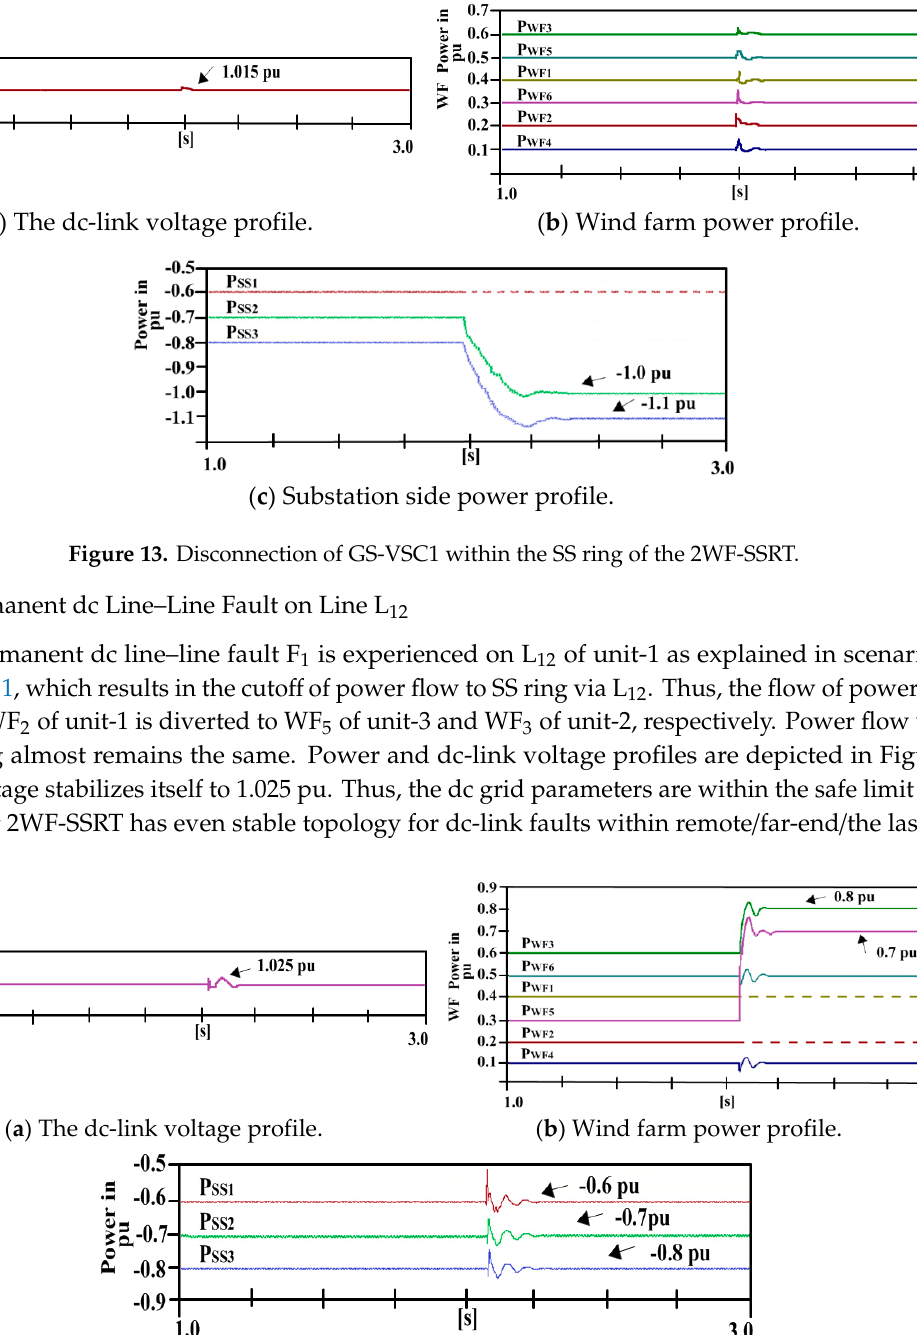
1 on cable L 12